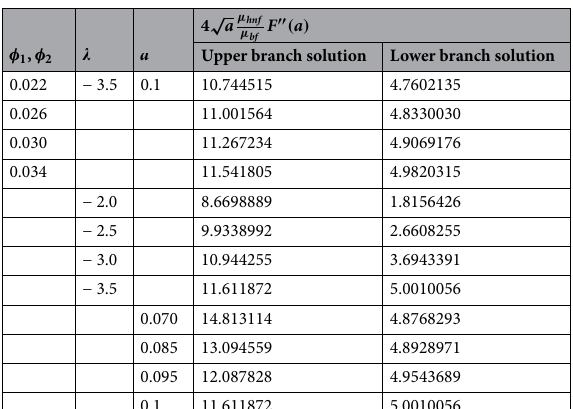
Table 3. The computational output values of drag force for several values of the mentioned parameters.